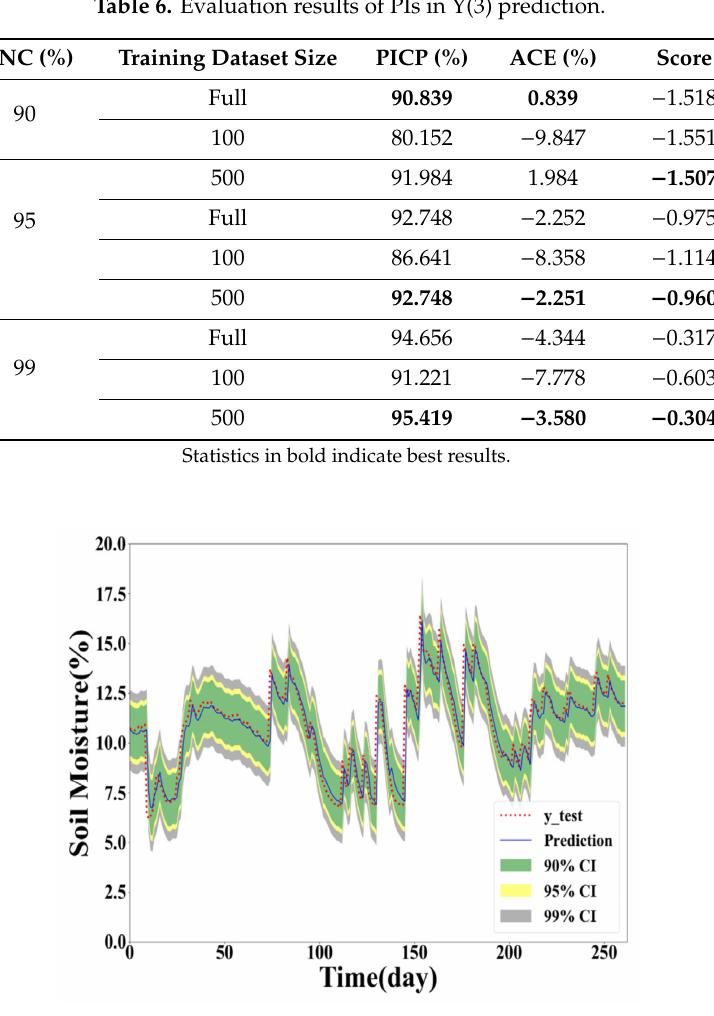
Figure 5. GPR model built with full training data in Y(1)